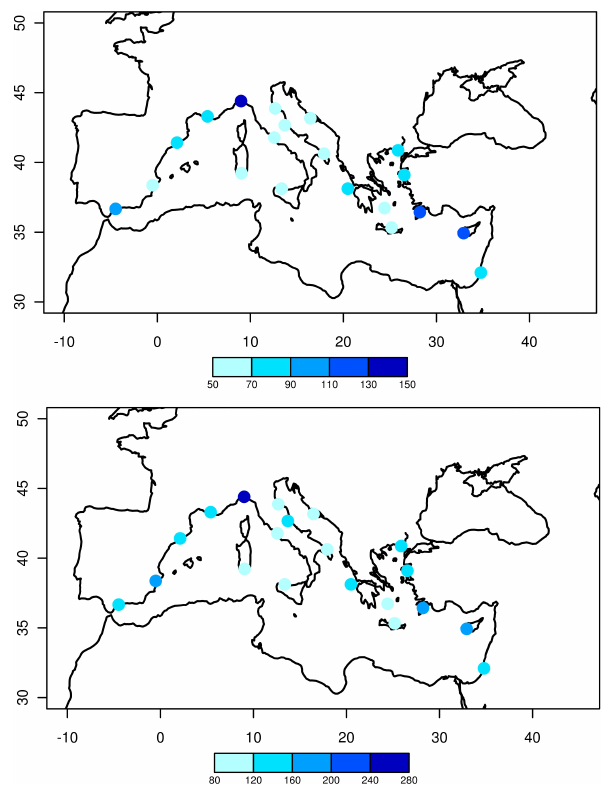
Fig. 2. Estimated 5-year (upper panel) and 50-year (bottom panel) return levels of each series. Values in